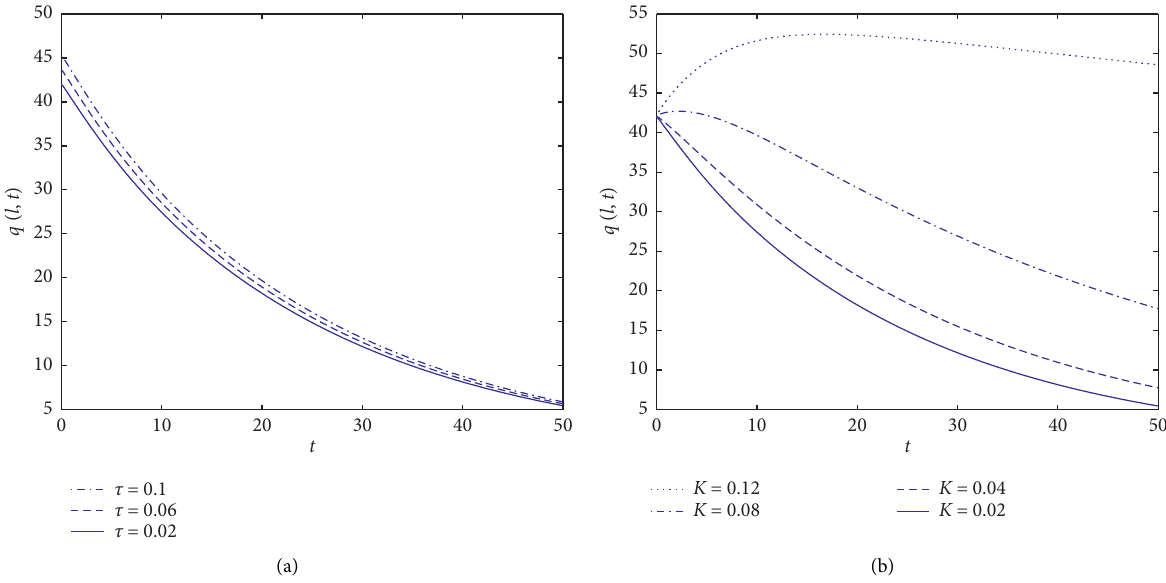
Figure 5: (a) q ( ℓ , t ) vs. time with the spatial distribution function b ( x ) � ( x / π ) − 1, q ( x, s ) � ( 1 + s )( π x 2 − x 3 /3 ) , α � 0 . 4 , β � 0 . 1 , and κ � 0 . 02 and for different values of τ . (b) q ( ℓ , t ) vs. time when α � 0 . 4 , β � 0 . 1 , τ � 0 . 02, and for different values of κ